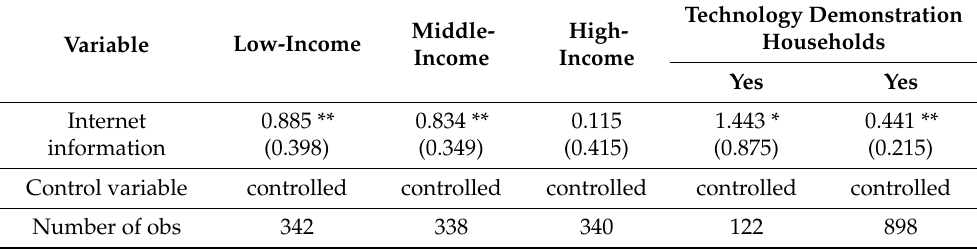
Table 6. The heterogeneity of income level and management ability.